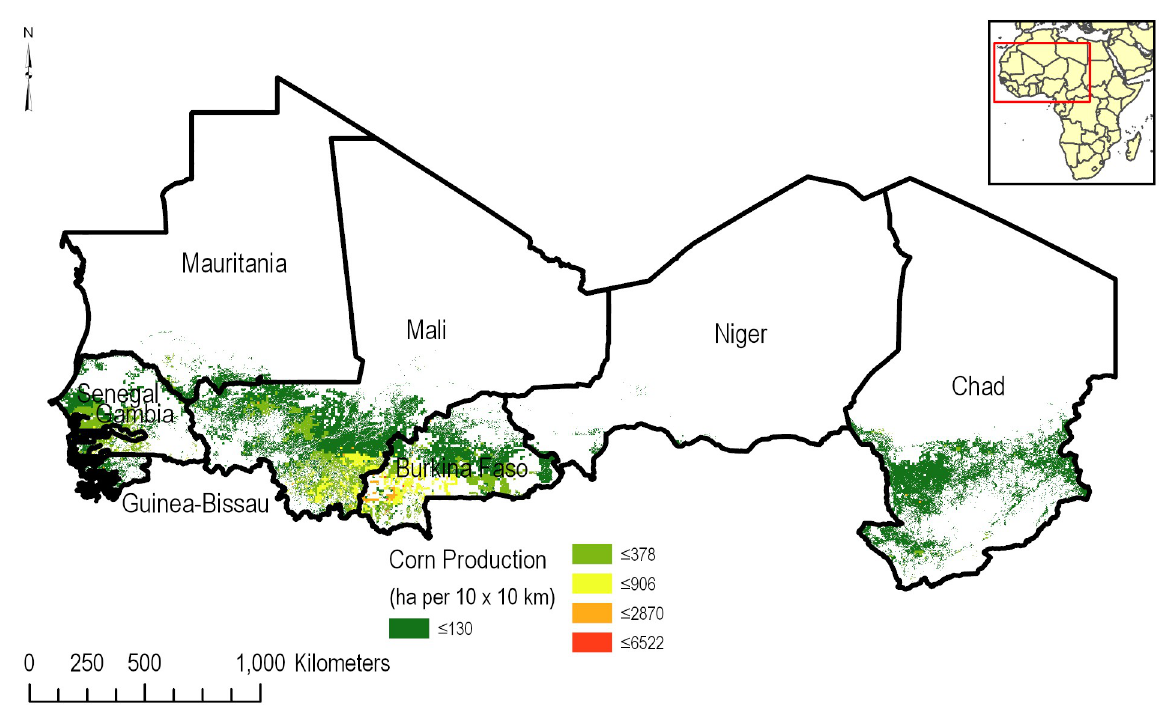
Fig 3. Distribution of corn production in the CILSS based on the 10 km x 10 km mapSPAM [9] data.